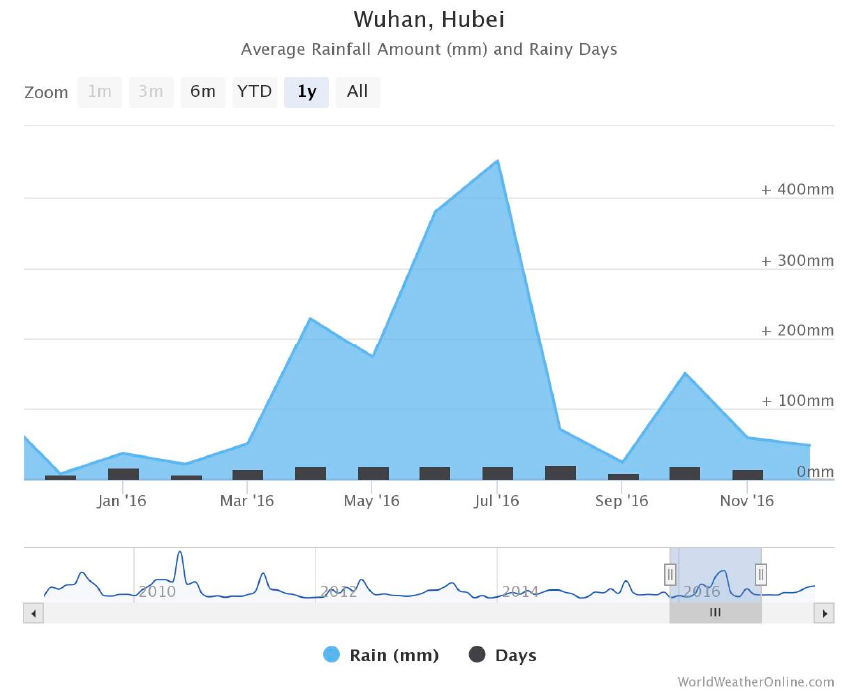
Figure 8. Monthly rainfall in Wuhan (2016). Data source: World Weather Online.